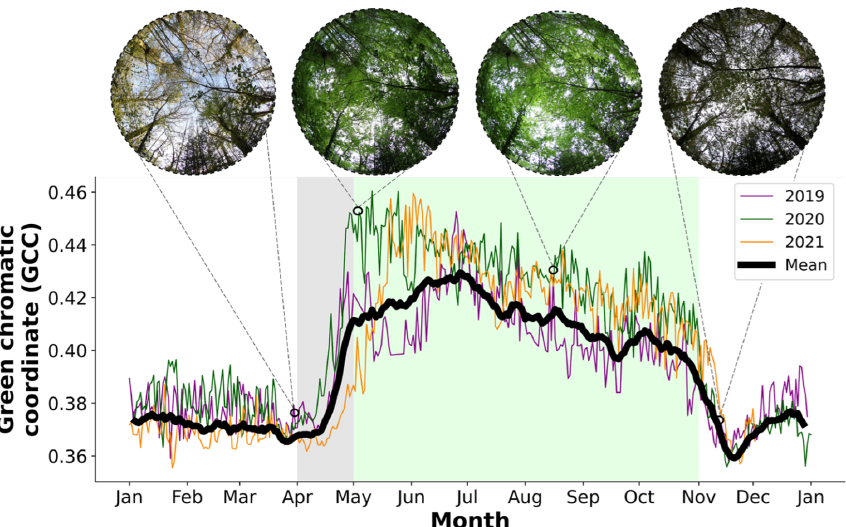
Figure 2. Time series of the green chromatic coordinate (GCC) derived from PhenoCam measurements (Sect. 2.2.1). The hemispheric photos are taken by cameras around 50cm above the ground in array 1 (Fig. 1 and site description in Sect. 2.1). Grey- and green-shaded regions show the leaf-off and leaf-on periods, respectively (as defined in Sect.